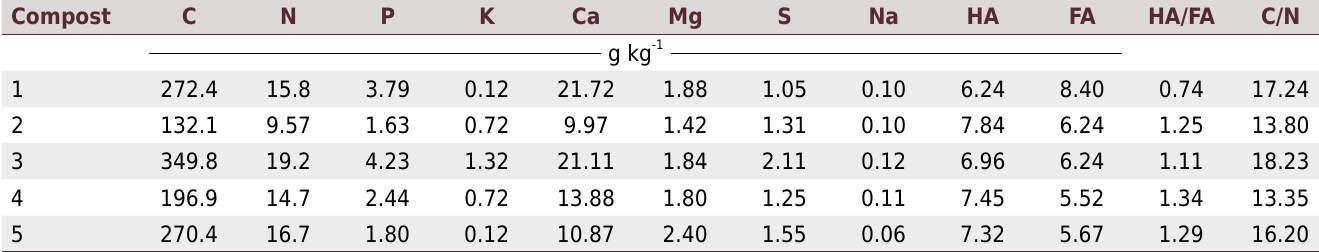
Table 2. Chemical characterization of the composts used in an area under mango in organic management